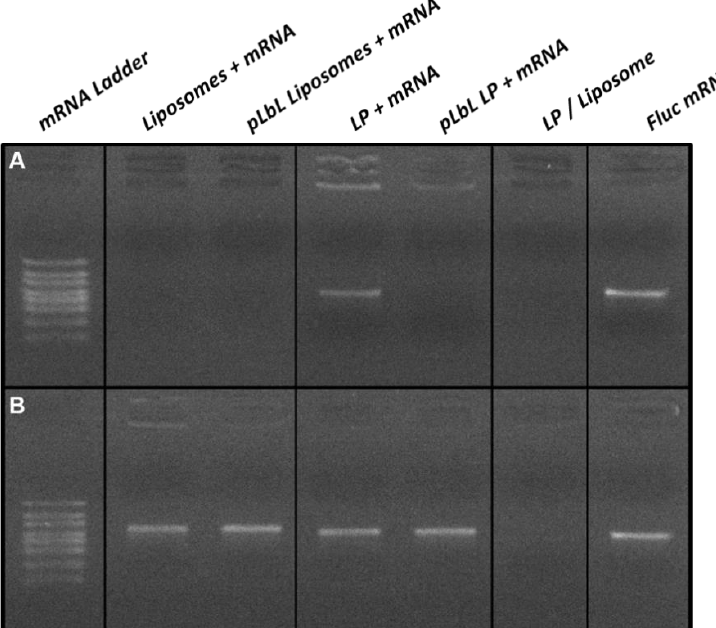
Figure 3. Agarose gel electrophoresis analysis of mRNA-based formulations ( A ) without and ( B ) with mRNA desorption treatment. For desorption treatment, samples were incubated at room temperature for 30 min and then treated with heparin (to desorb mRNAs and peptides) and proteinase K (to degrade peptides) at 56 °C for 15 min.